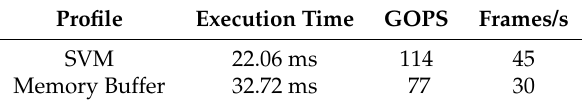
Table 7. Execution times of the guided filter on HARP with and without shared virtual